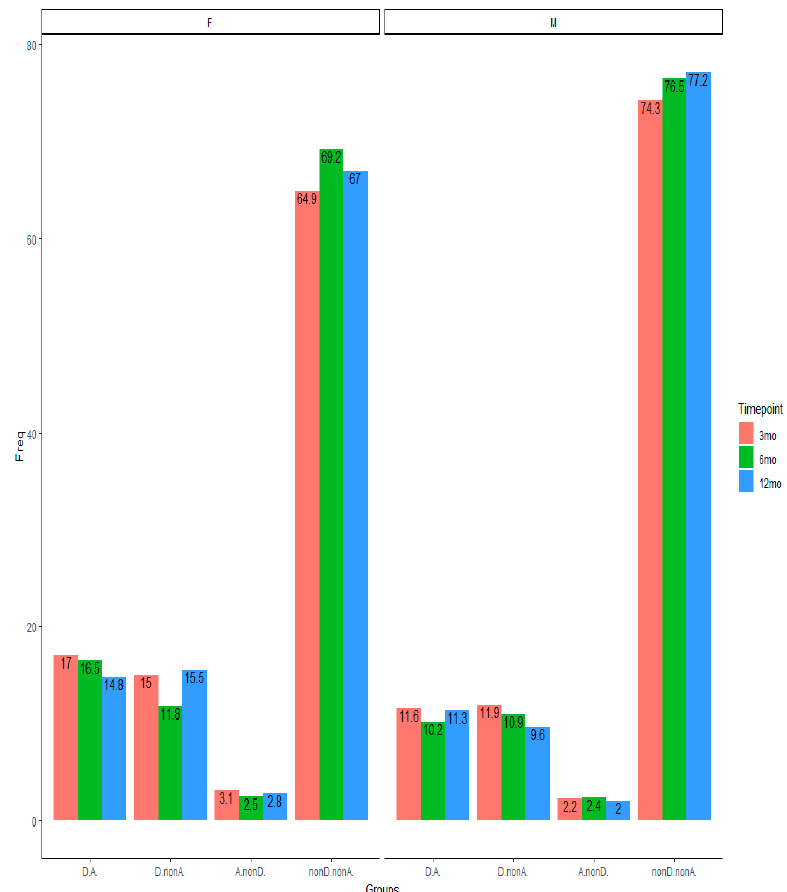
Figure 2. Theprevalence(%)ofdepressionandanxietycategoriesatthreetimepointsof3, 6, and12months. Figure 2 . The prevalence (%) of depression and anxiety categories at three time points of 3, 6, and 12 Note: F = female; M = male. nonD.nonA. = neither depression nor anxiety; A.nonD. = only anxiety; months. Note: F = female; M = male . nonD.nonA. = neither depression nor anxiety; A.nonD. = only D.nonA. = only depression; D.A. = comorbid depression and anxiety; D.nonA. = only depression; D.A. = comorbid depression and anxiety.